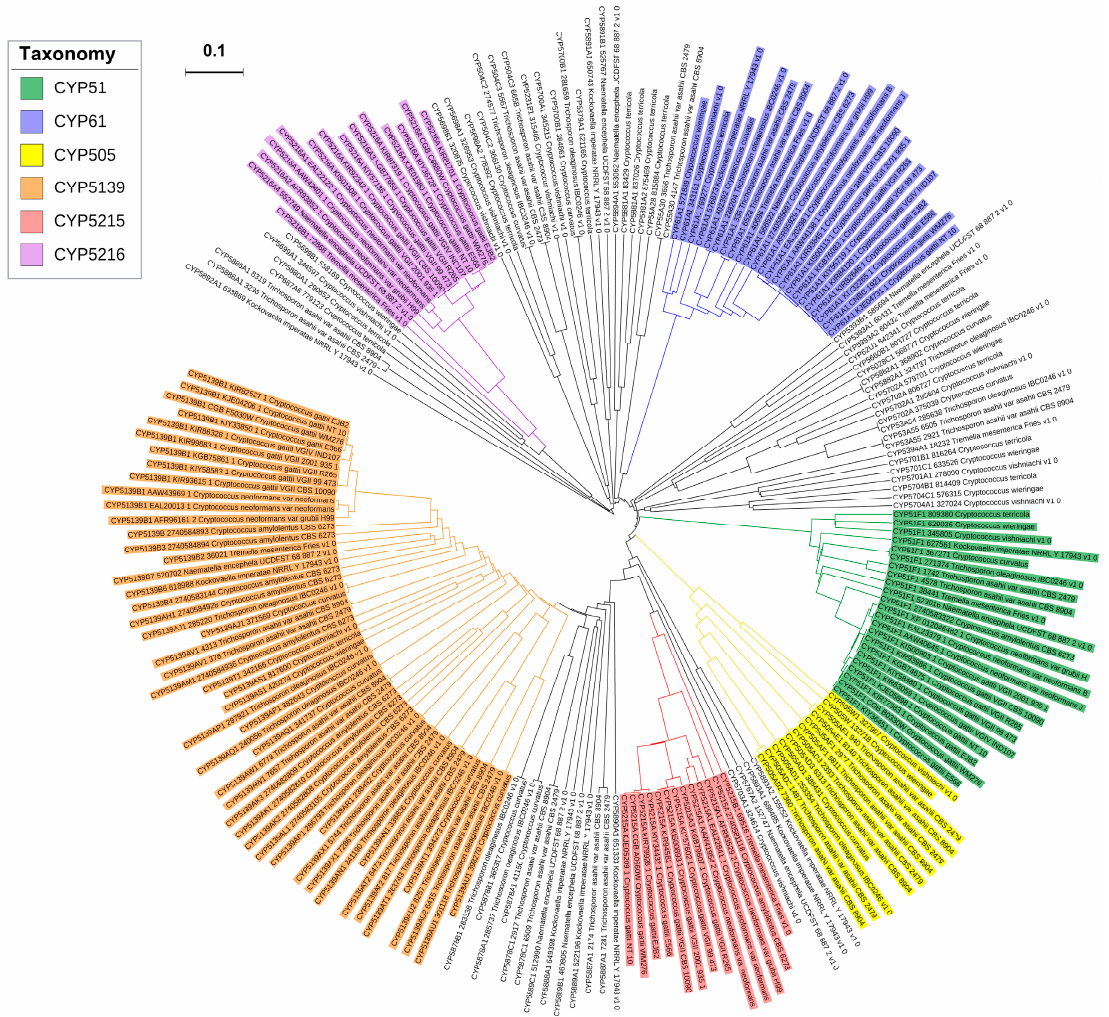
Figure 2. Phylogenetic analysis of CYPs from the species of Tremellomycetes . CYP families that are highly populated in species of Tremellomycetes are indicated in different colors. A high-resolution phylogenetic tree is provided in Supplementary Figure S1.